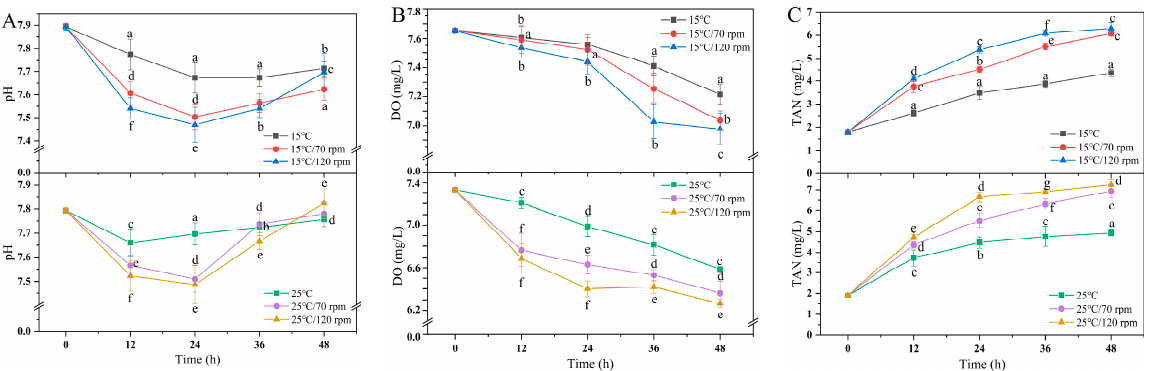
Figure 2. Changes in ( A ) water pH, ( B ) DO, and ( C ) TAN during transport. Values were obtained from average of all samples and given as means ± SD (n = 5). Different letters indicate significant differences among the treatments.